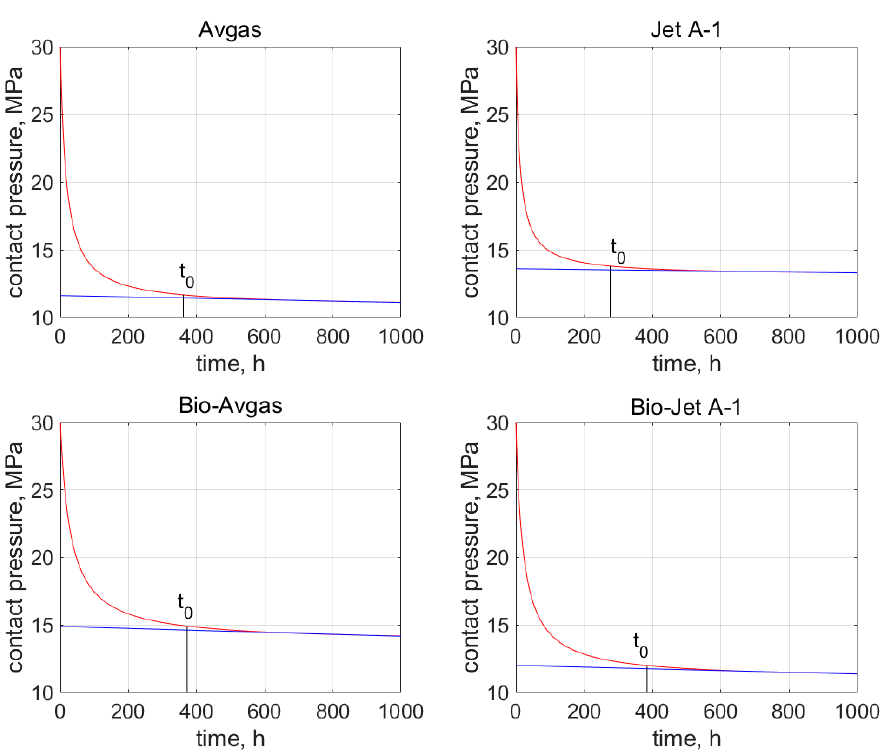
Figure 7. Time t 0 from when the secondary creep starts, which is marked in the contact pressure graph (red curve) for the AFO gasket and all the tested fuels. The blue line indicates the linear de- crease of constant pressure.